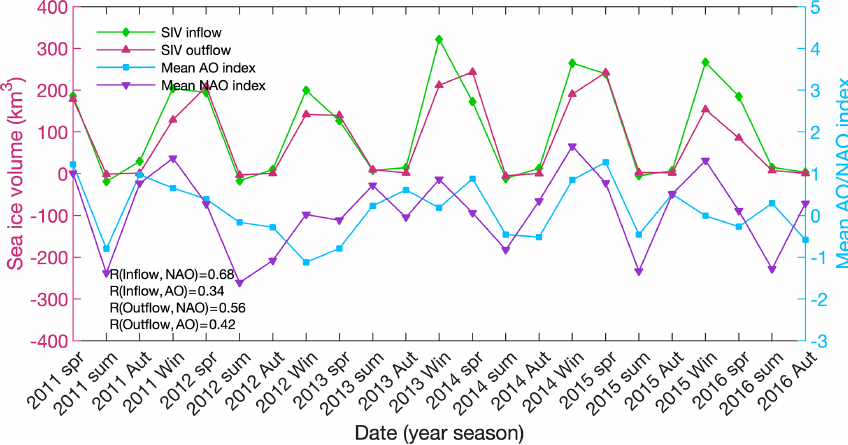
Figure 7. Time series of seasonal mean SIV inflow (green line) and outflow (violet red line) in the Baffin Bay. The NAO (purple line) and AO (cyan line) indexes are averaged in the same period. R represents the correlation coefficient between the NAO and AO indexes and inflow and